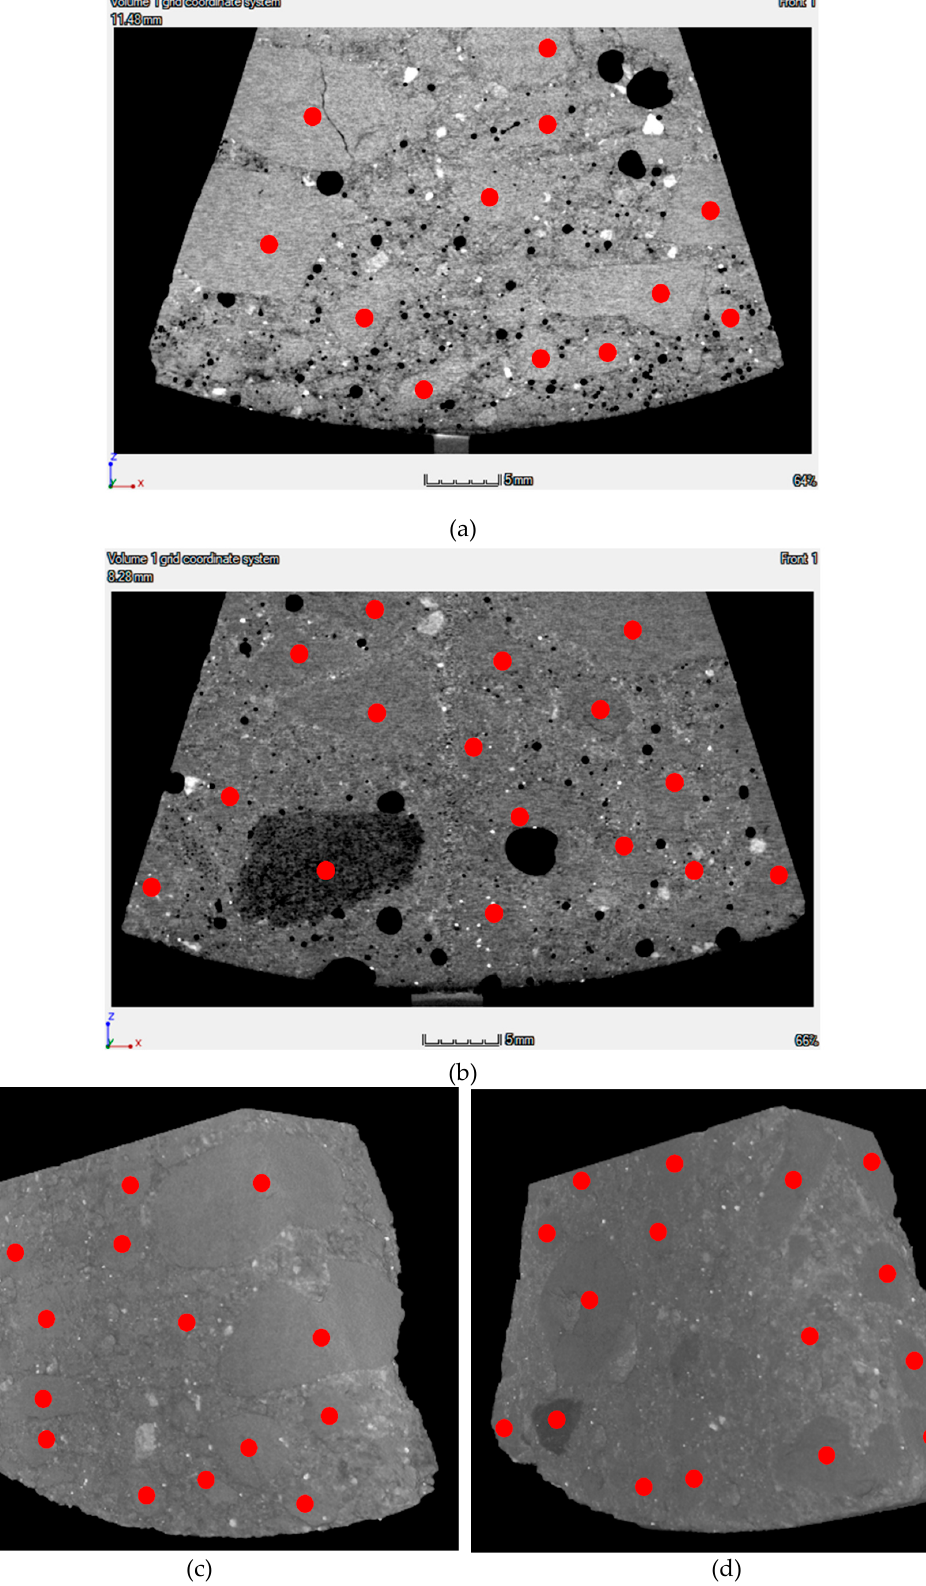
Figure 7. The 2D images for ( a ) C47 and ( b ) S42 and computed 3D images for ( c ) C47 and ( d ) S42. The red circles mark the visible aggregates.